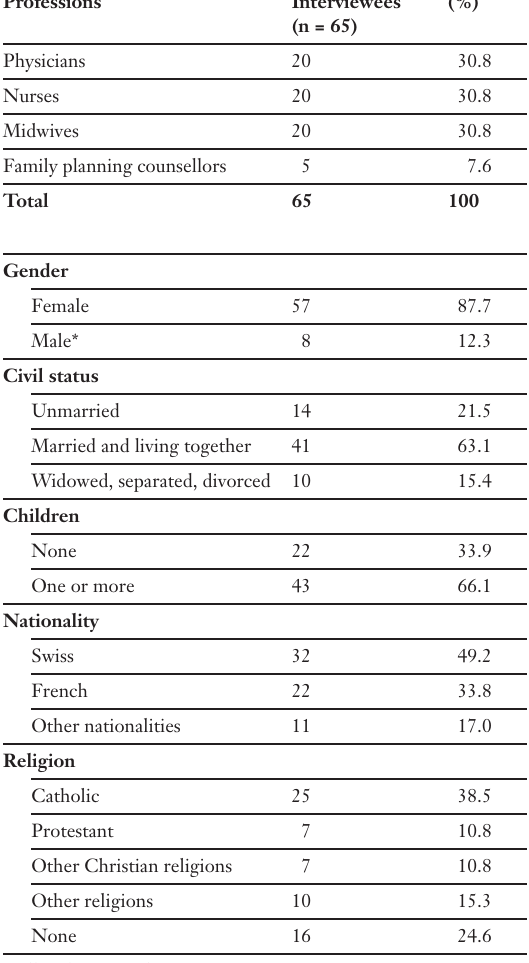
Table 2 Study sample